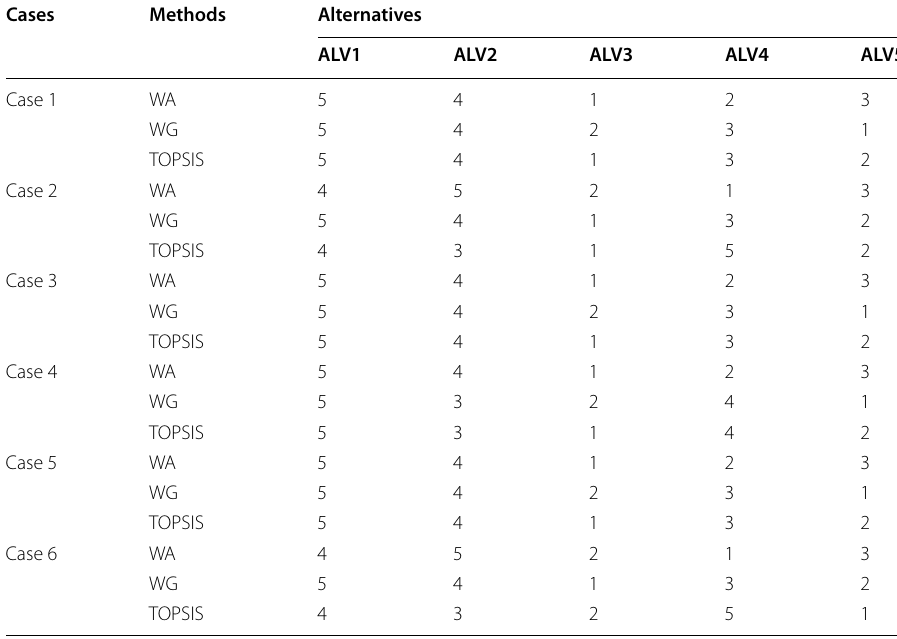
Table 16 Sensitivity analysis results based on q-ROF DEMATEL